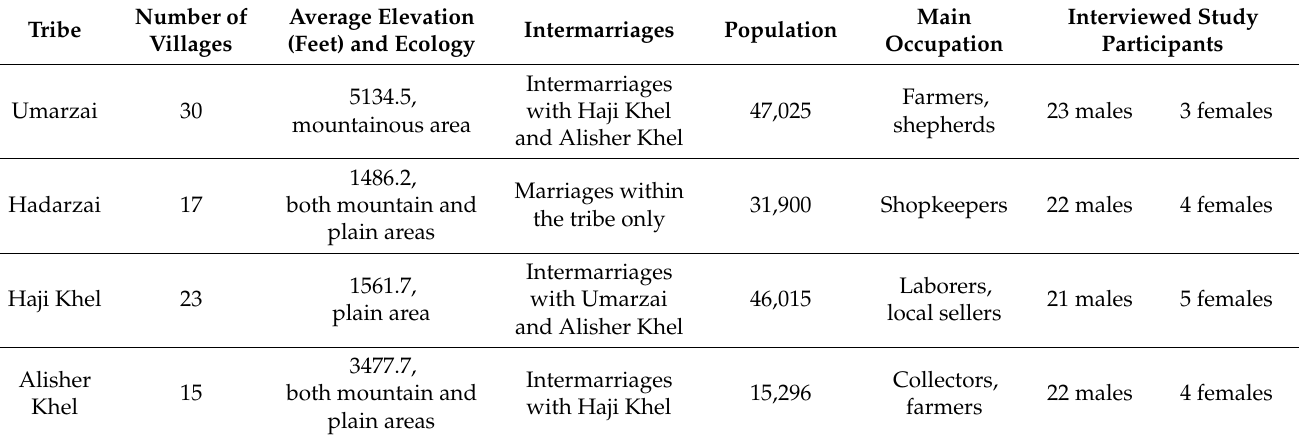
Table 2. Main ecological and social characteristics of the study